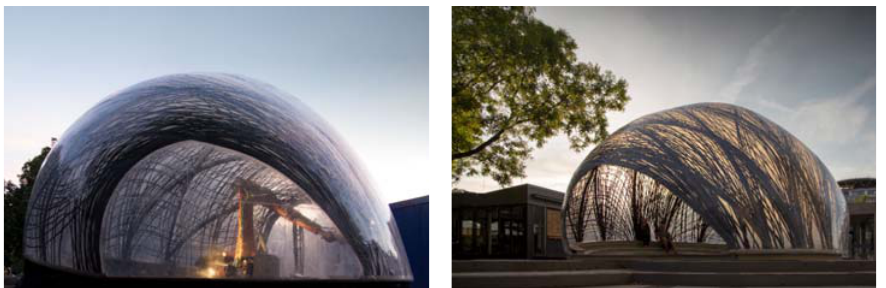
Figure 15: Inflated pavilion strengthened with carbon fibers which are applied by a robot arm [19] © ICD/ITKE University of Stuttgart.